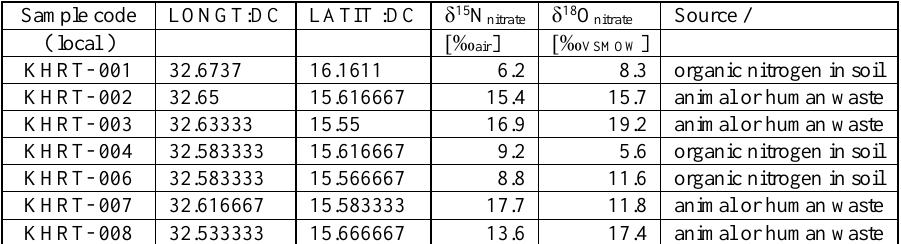
Table 4. Result of δ 15 N nitrate and δ 1 8 O nitrate ,